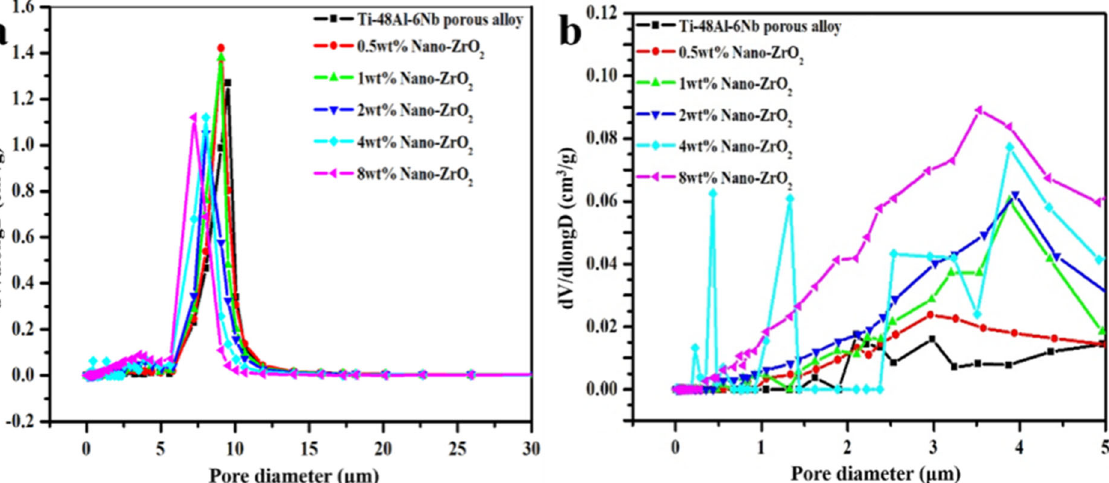
Fig. 3 Pore diameter distribution curve of Ti-48Al-6Nb porous alloy and PCMM. a Ti-48Al-6Nb porous alloy (black) and PCMM with 0.5 wt.% (red), 1 wt.% (green), 2 wt.% (blue), 4 wt.% (cyan) and 8 wt.% (magenta) Nano-ZrO 2 additions; b locally magni fi ed curves of Fig. 3a. Table 1. Pore parameter for Ti-48Al-6Nb porous alloy and PCMM with different amounts of Nano-ZrO 2 addition (0.5 – 8 wt.%). Pore parameter Ti-48Al-6Nb 0.5